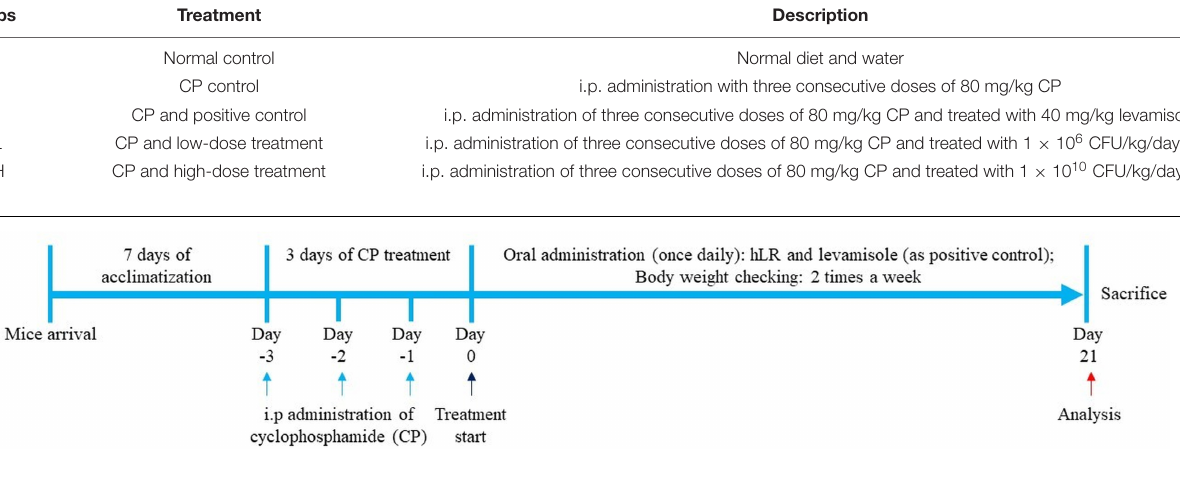
FIGURE 1 | Experimental